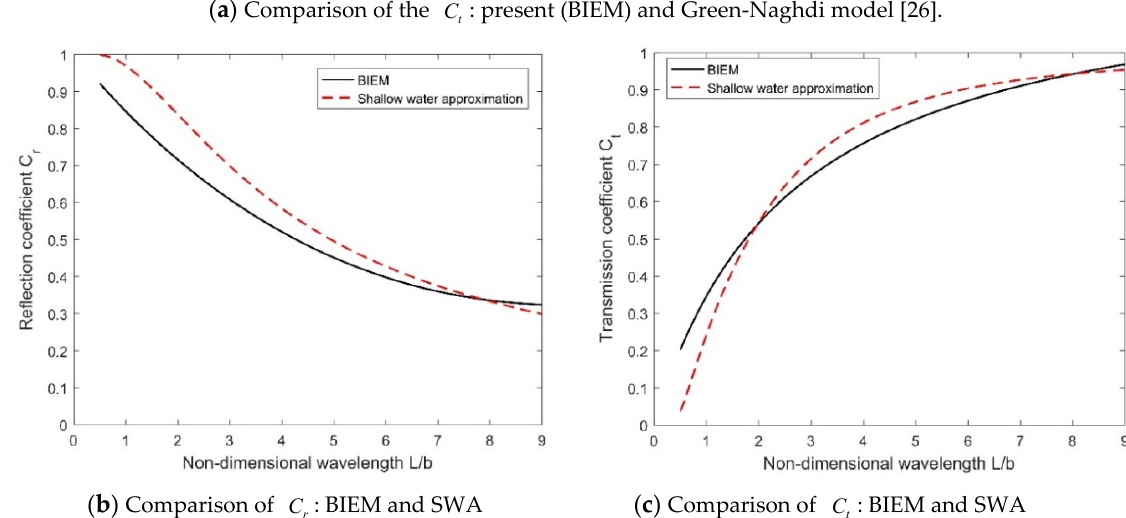
Figure 4. Comparison of present BIEM with Green-Naghdi model [26] and SWA of the reflection and the transmission